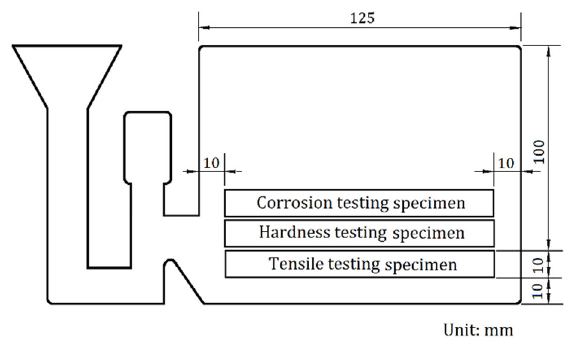
Figure 1. Schematic representation of specimen position in casting.